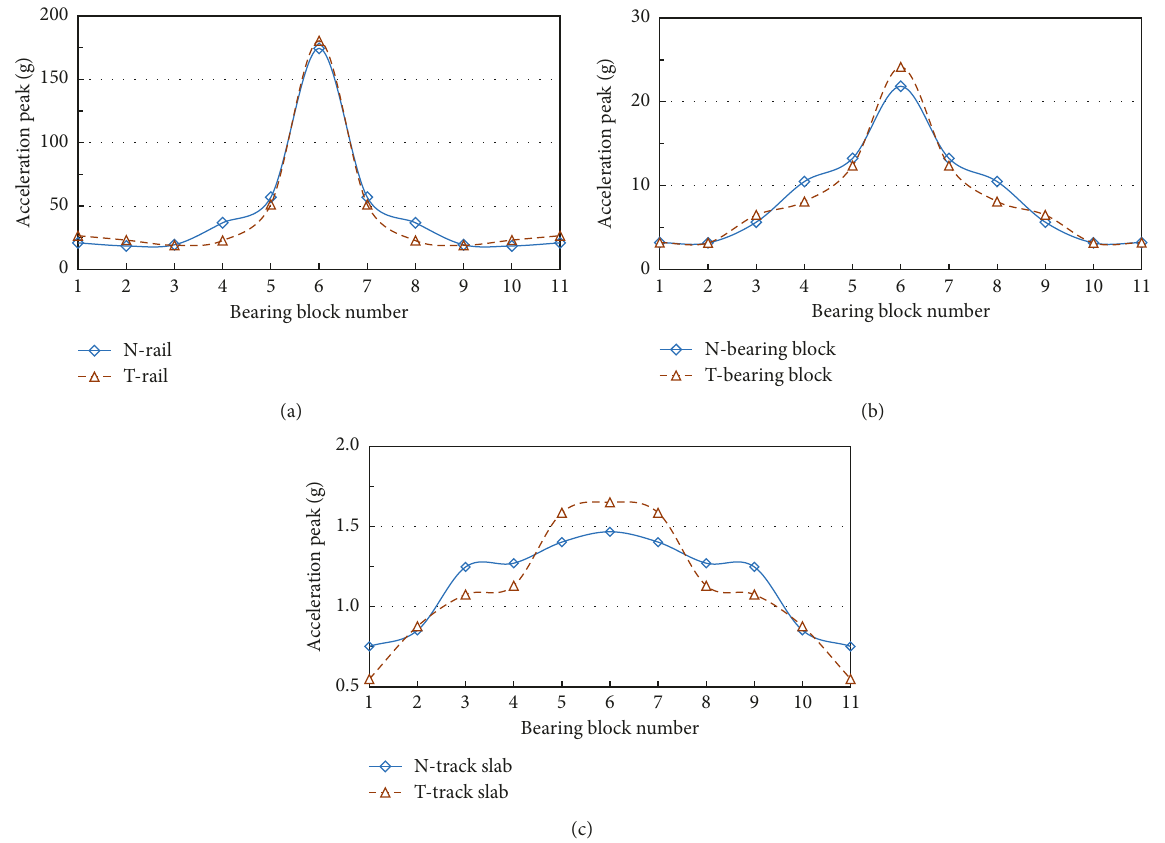
Figure 9: Longitudinal acceleration distribution peak along the track. (a) Rail acceleration peak. (b) Bearing block acceleration. (c) Track slab acceleration